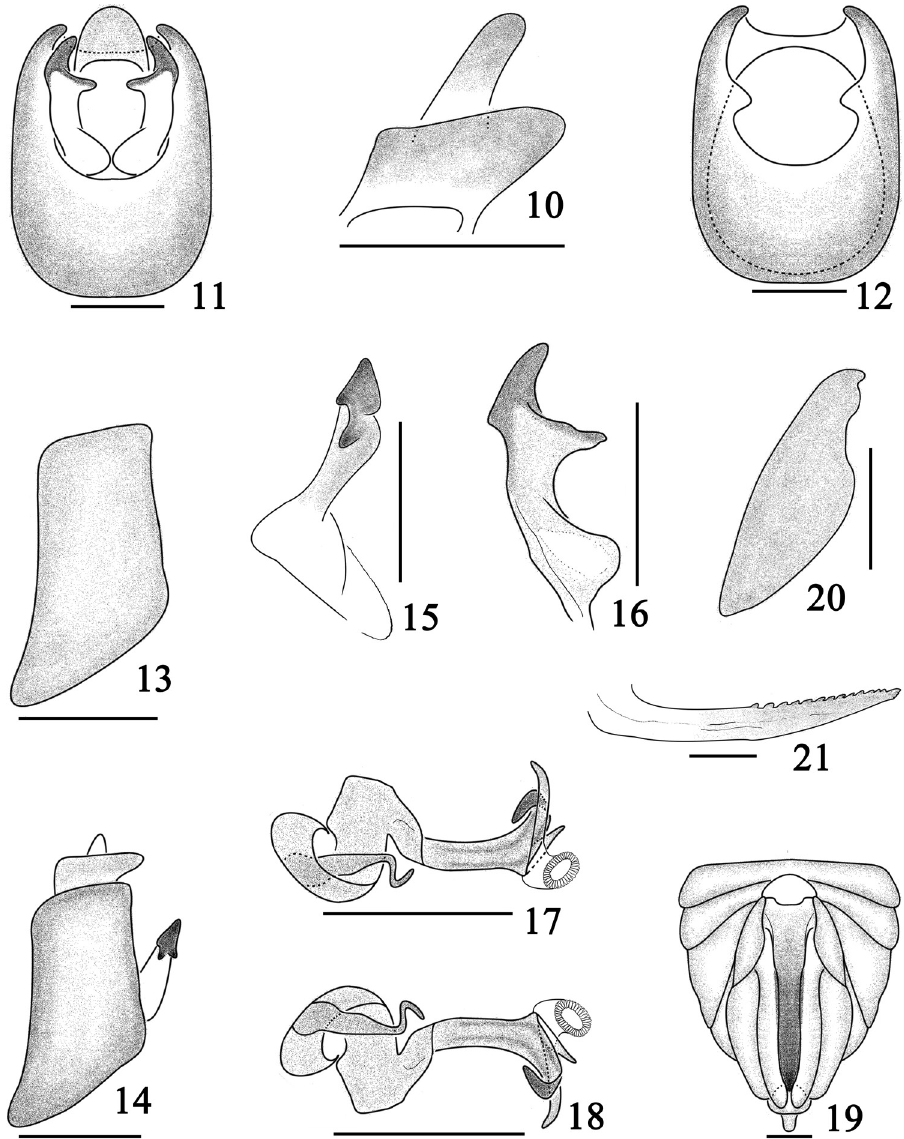
Figures 10–21. Bambusiphaga yingjiangensis sp. n. 10 Anal segment, lateral view 11 Male genitalia, pos- terior view 12 Pygofer, posterior view 13 The same, lateral view 14 Male genitalia, lateral view 15 Genital style, lateral view 16 Same, posterior view 17 Aedeagus, right lateral view 18 Same, left lateral view 19 Fe- male genitalia, posterior view 20 Gonocoxa VIII, posterior view 21 Gonapophysis IX. Scale bars 0.2 mm. Head and thorax . Vertex with anterior margin broadly rounded, lateral and submedi- an carinae distinct, ratio width at base to width at apex 1.4, ratio of length to width at base 0.5 (Figs 3–4). Frons with ratio of length at midline to width at widest part